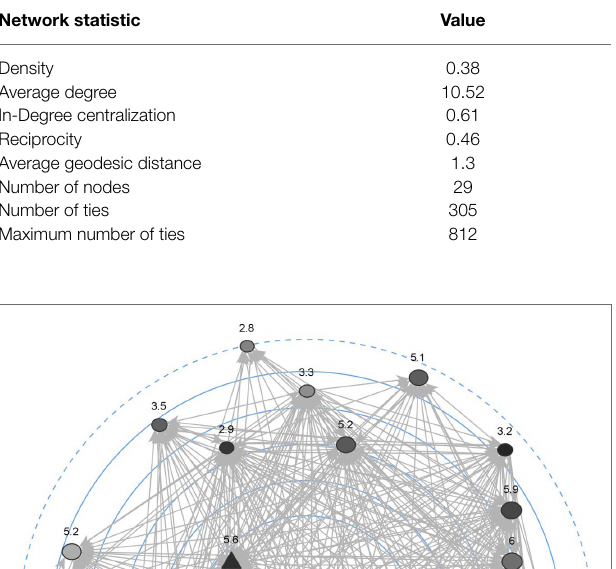
TABLE 2 | Descriptive network statistics of the leadership network. Network statistic